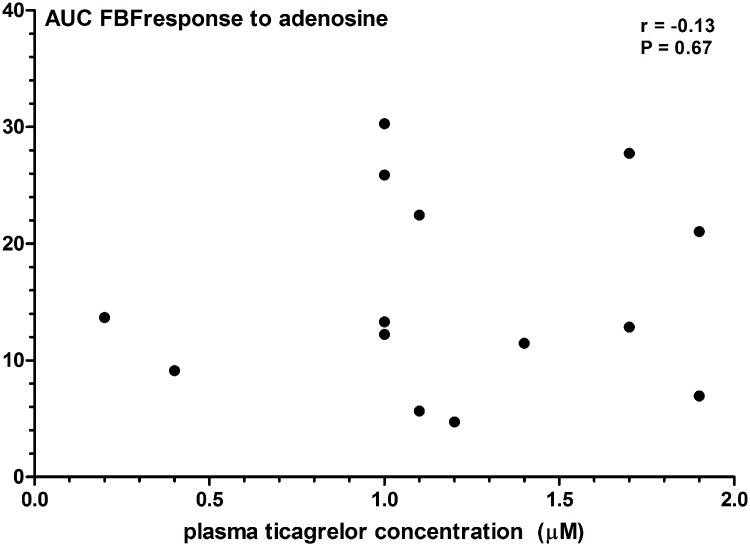
The correlation between the plasma ticagrelor concentration and the area under the curve (AUC) of adenosine-induced forearm vasodilation.